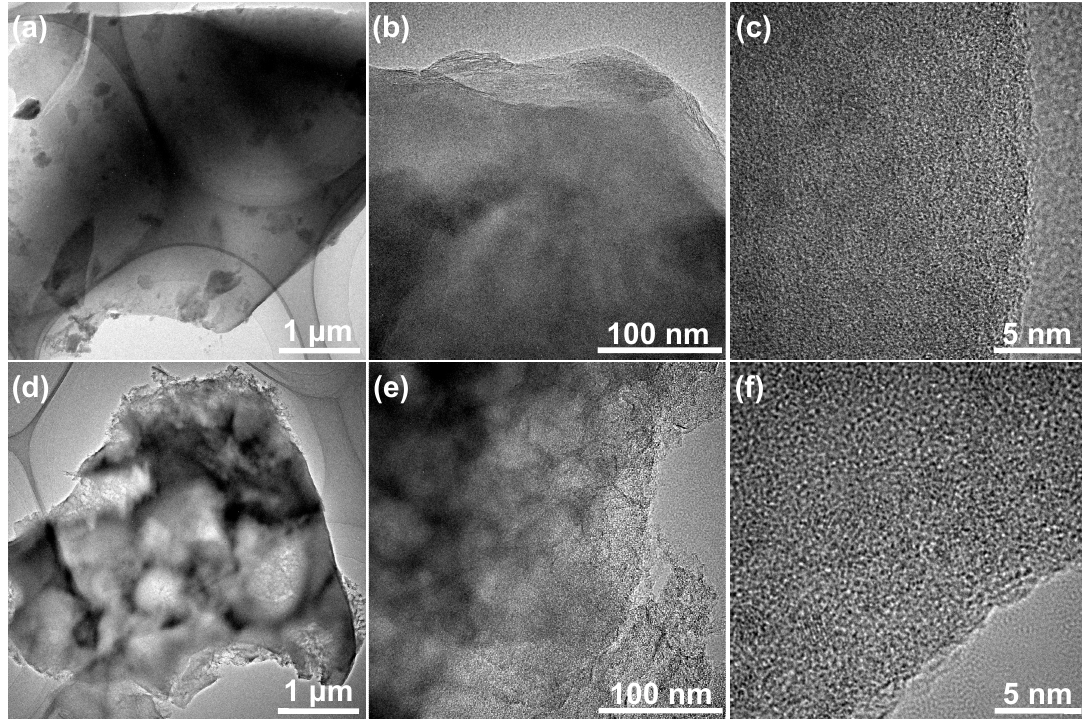
Figure 3. TEM images of ( a – c ) HPC-0 and ( d – f ) HPC-2 at different magnifications.